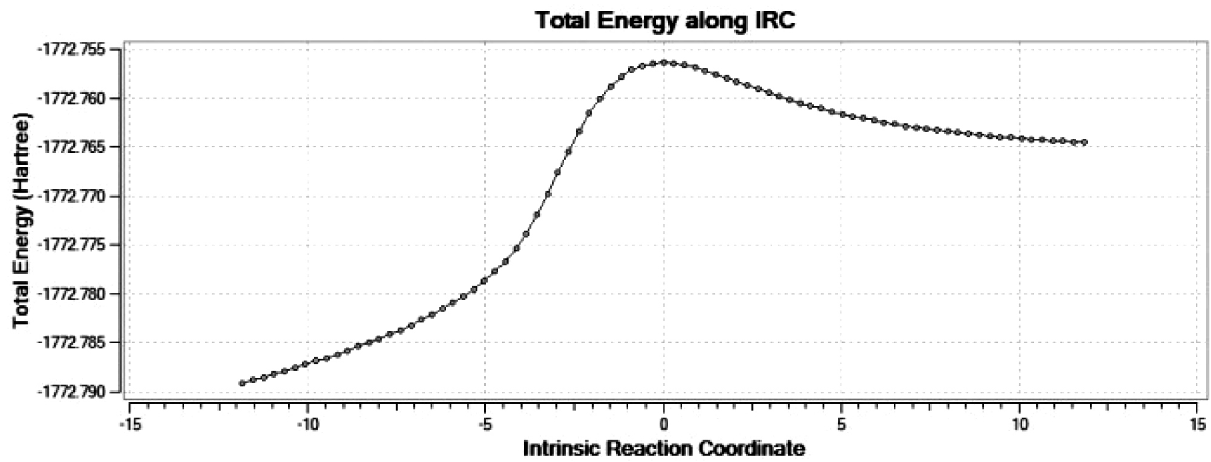
Figure 2. B3LYP/6-311G (d,p) IRC plot for the pathway of 1,3-DC reaction between 1a and 2 leading to 3a.